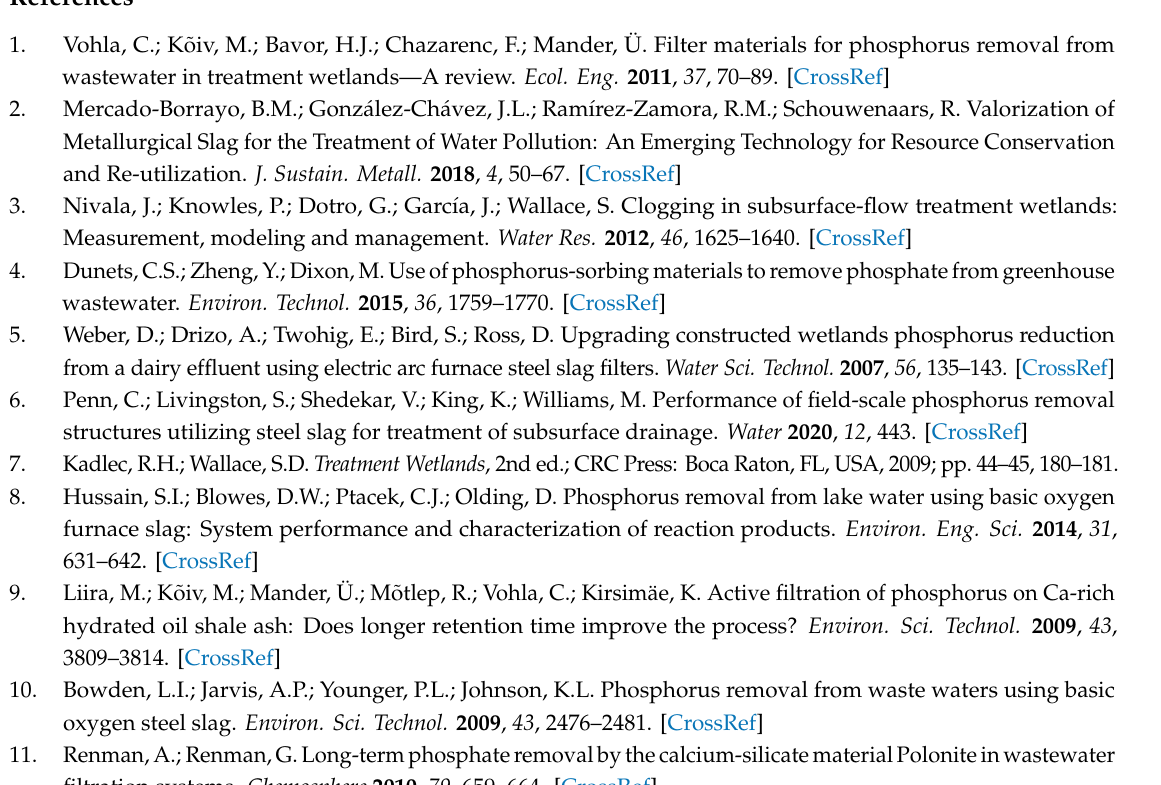
Table S1: Measurement of the hydraulic conductivity of column 2 at t = − 1 d using a constant head protocol, Figure S1: Precipitate sampling by washing and sedimentation in a pan, Figure S2: XRD pattern of precipitates sampled in column 2, cell 1, Figure S3: Tracer test calibration in column 1 at di ff erent times of operation (indicated at the top right corner), Figure S4: Tracer test calibration in column 2 at di ff erent times of operation (indicated at the top right corner), Figure S5: Pictures of column cross-sections at the interface between cells 2 and 3. A: column 1, showing black slag with a uniform distribution of white precipitates. B: column 2, showing irregular distribution of precipitation into zones of either black slag with few precipitation, or red slag with heavy cementation, Figure S6: Pressure head buildup in column 1. The vertical dashed line indicates the reduction of influent flowrate from 6.9 ± 1.3 mL / min to 3.4 ± 0.5 mL /